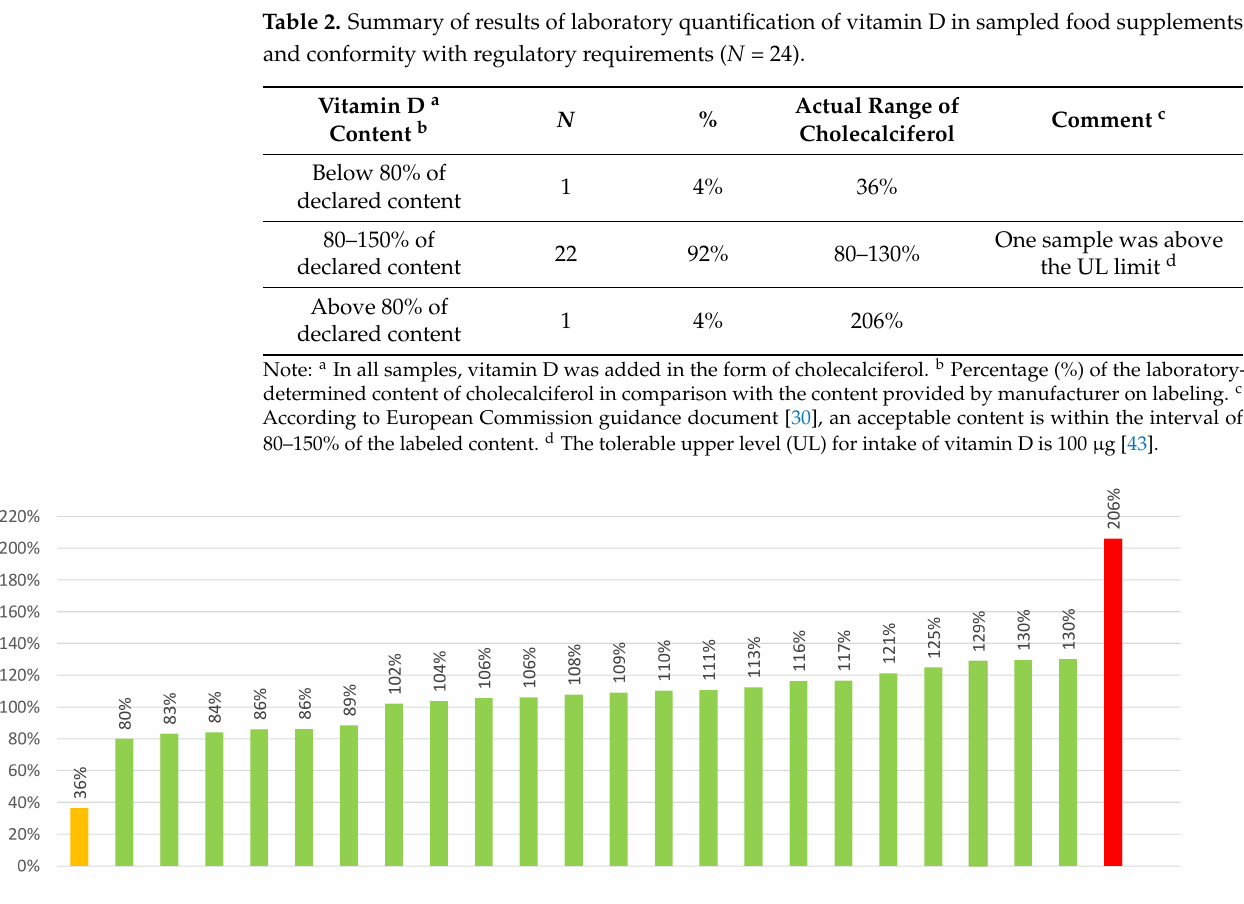
Figure 2. Analytically determined content of vitamin D in samples of food supplements as a percentage (%) of the content provided by manufacturer on labeling ( N = 24). Each row represents one analyzed food supplement. Note: yellow (vitamin D content below the 80% of the labeled value); green: (80-150%); red: (above